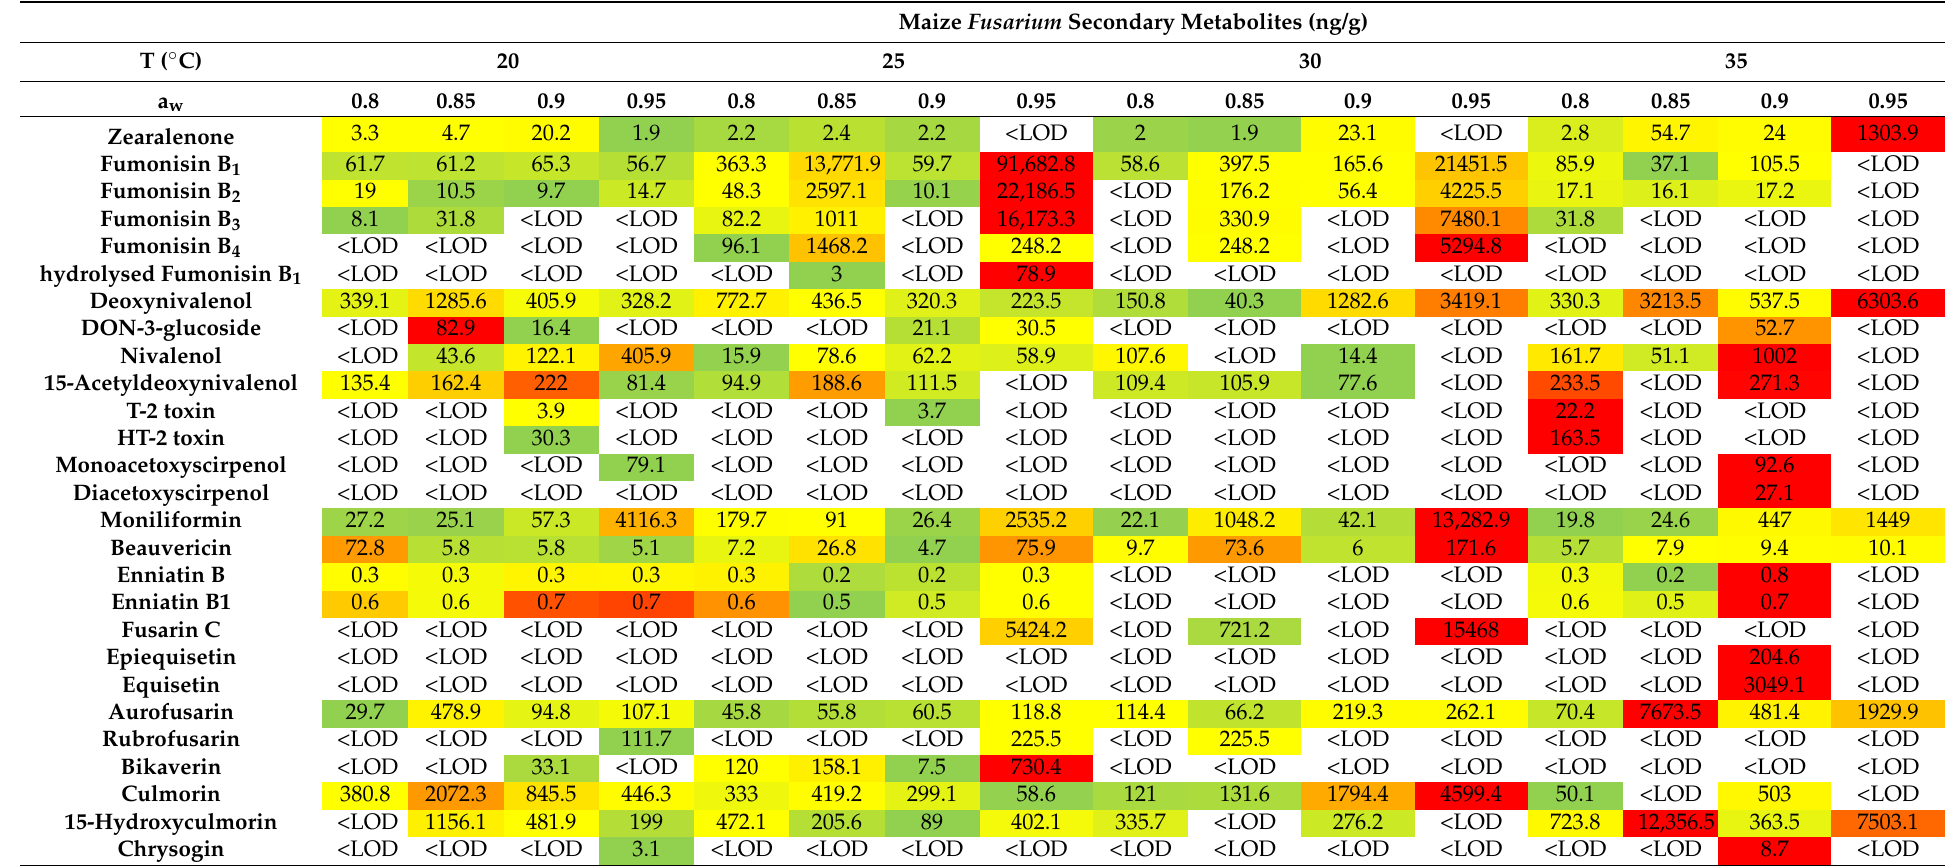
Table 4. Detailed list of the quantified major secondary metabolites of Fusarium species detected in the maize under different temperature × water activity conditions. The conditions highlighted in green (low concentrations), yellow (medium concentrations) and red (highest concentrations) were found. LOD: Limit of